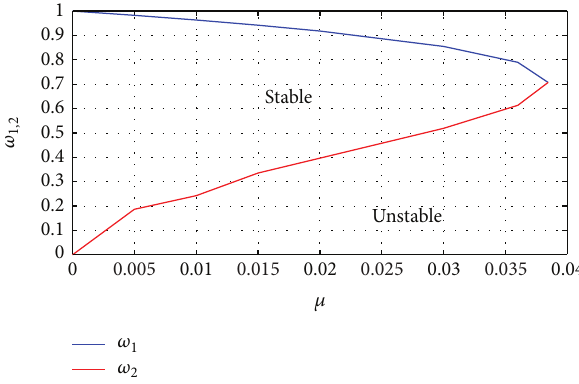
Figure14:Correlationbetween 𝜇 and 𝜔 1,2 forbinarysystemAchird- I.